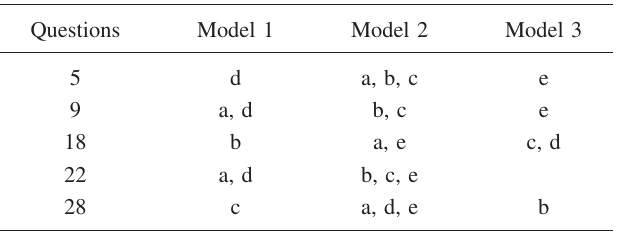
TABLE I. Associations between the physical models and the choices of the five FCI questions on the force-motion